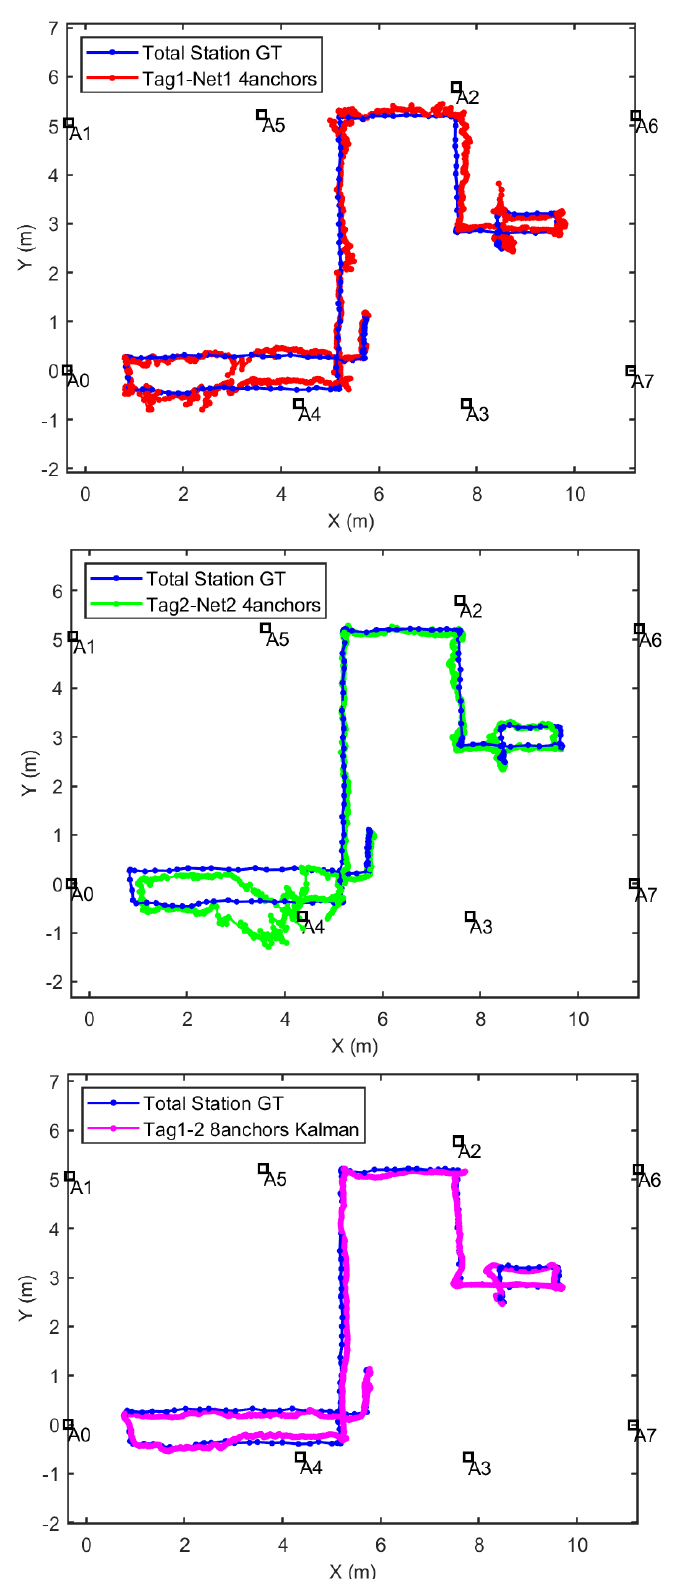
Figure 14. Location results with the estimation methods proposed in this work, and comparison with the ground-truth (GT) supplied by the S6 Total station. Top: Tag1 estimation by Decawave algorithm with four ranges in Network1. Middle: Tag2 estimation by the Decawave algorithm with four ranges in Network2. Bottom: Tag1-Tag2 pair estimation by EKF algorithm with eight ranges using both